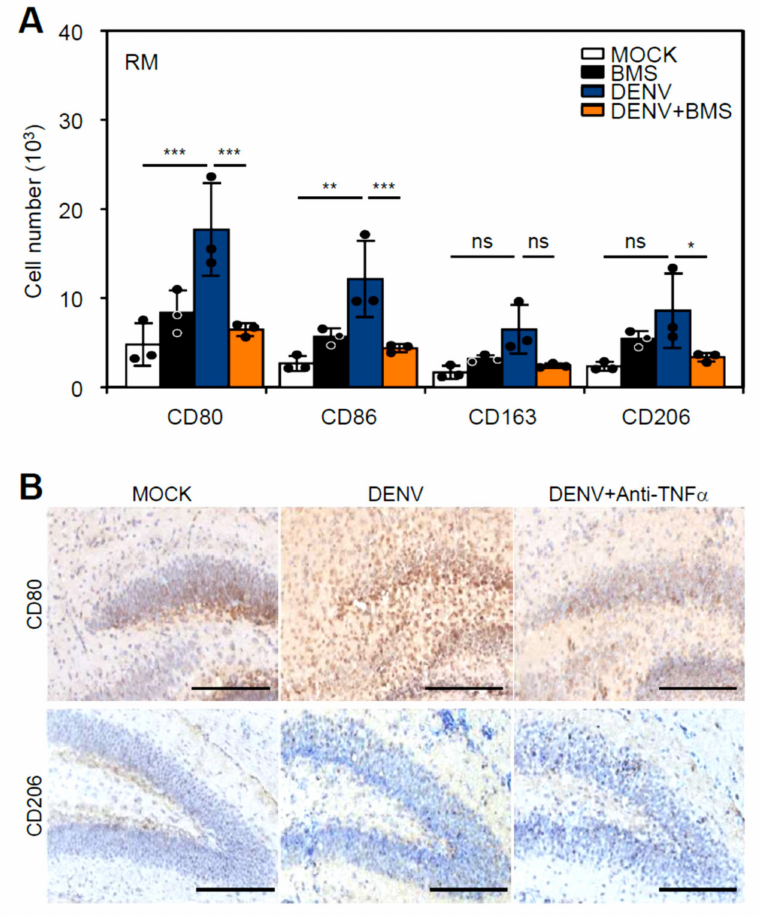
Figure 5. Pharmacologically inhibiting CCR2 and TNF- α reduced resident microglial polarization. Neonatal ICR mice were kinetically pretreated with the CCR2 antagonist BMS (10 mg/kg) for one